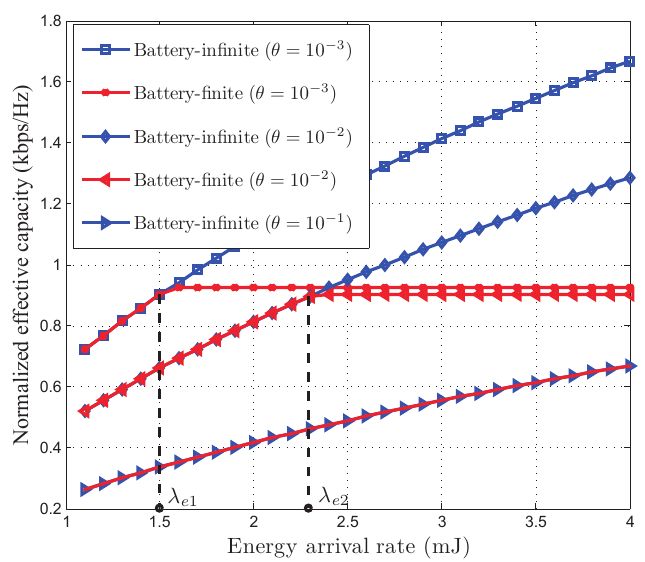
Figure 7. The normalized effective capacity of our developed QoS-driven power control policies versus energy arrival rate for battery-infinite/finite energy harvesting based wireless sensor